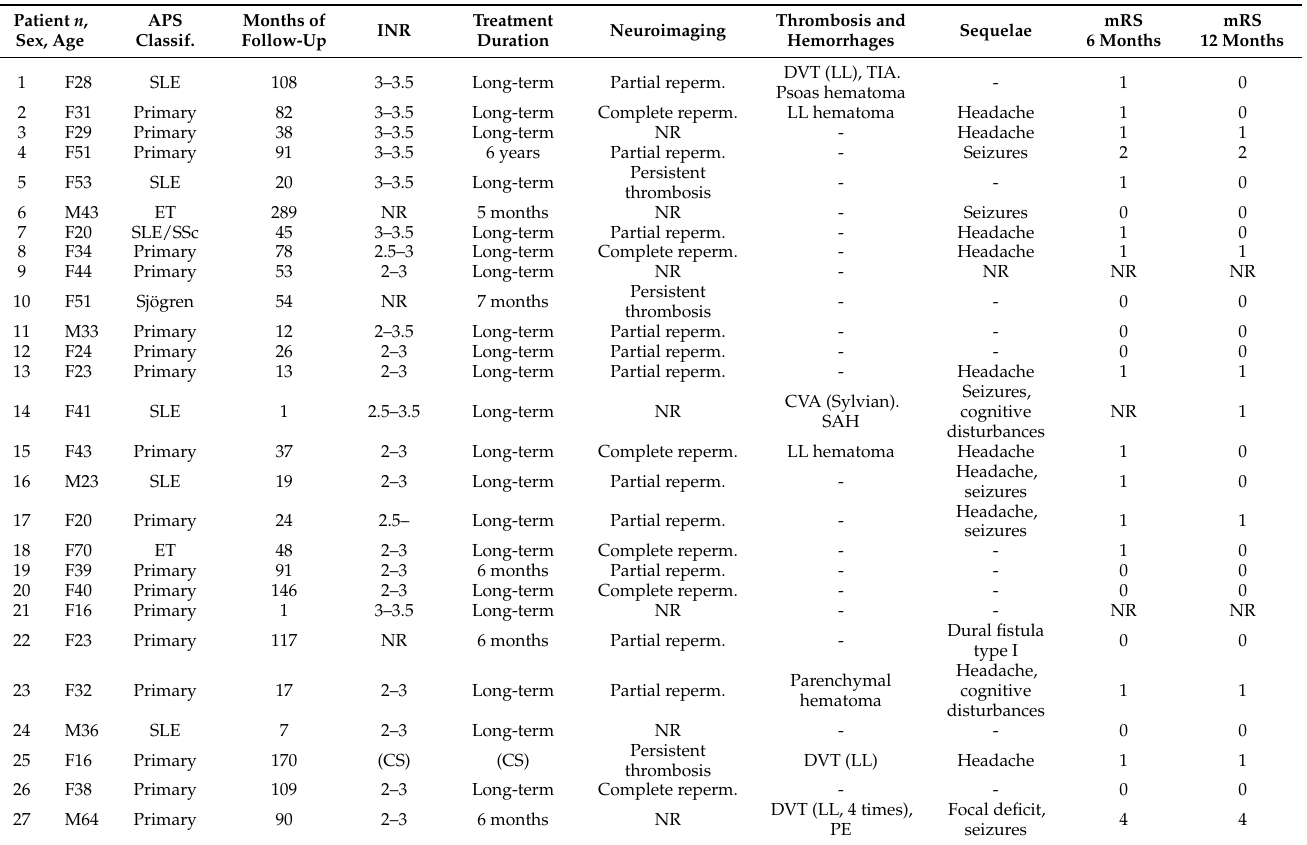
Table 4. Evolution of CVT patients during follow up. This table gathers the main information about the evolution of CVT patients during follow up. Abbreviations: NR, not reported; CS, corticosteroids; SLE, systemic lupus erythematosus; ET, essential thrombocytosis; SSc, systemic sclerosis; DVT, deep vein thrombosis; UL, upper limbs; LL, lower limbs; PE, pulmonary embolism; CVA, cerebrovascular accident; mSR, modified Rankin Scale. Patient n , APS Sex, Age